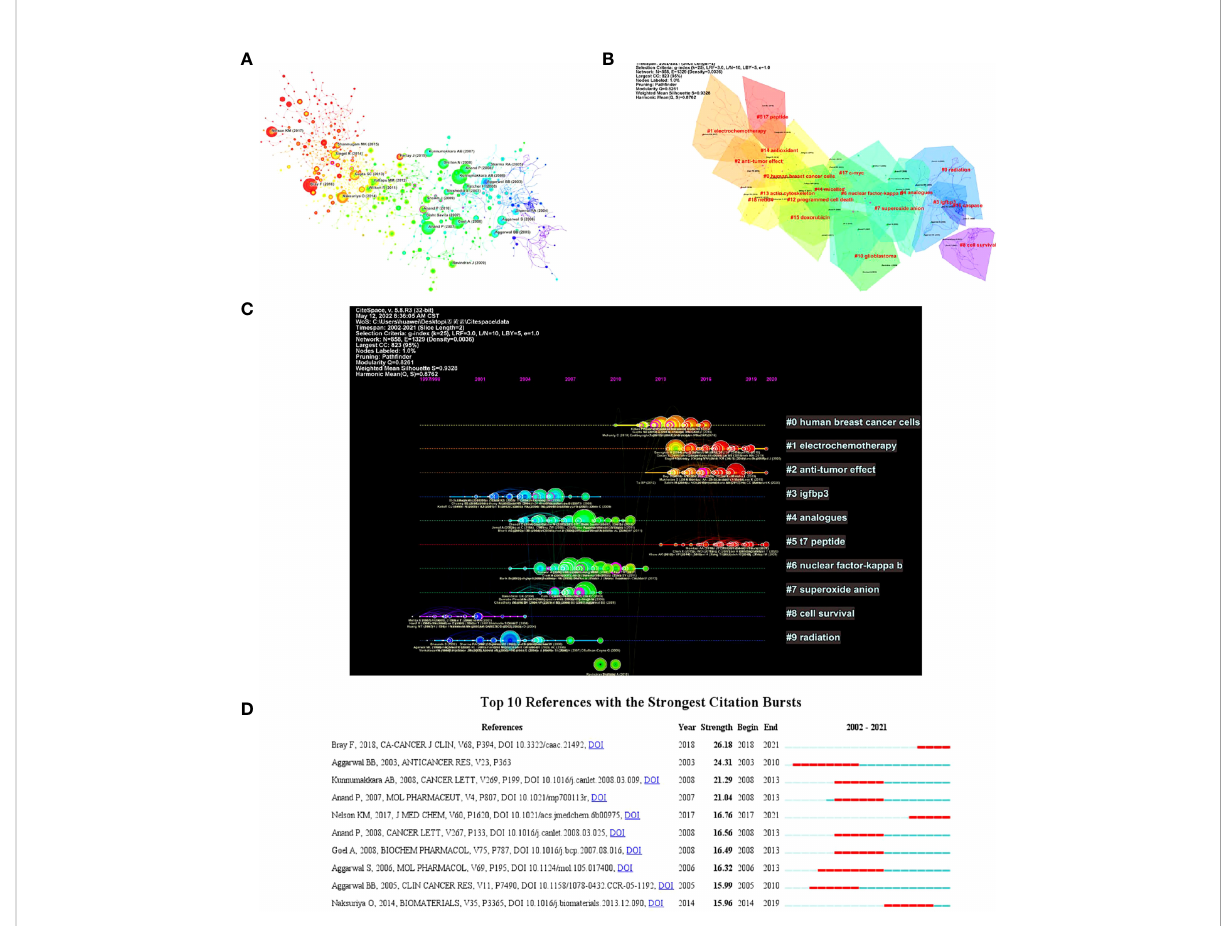
FIGURE 9 Cocitation analysis of references. (A) Network visualization analysis of co-cited References. (B) Cluster Analysis of Co-cited References. (C) Timeline view of references in the fi eld of curcumin and tumor. (D) The top 10 references with the strongest citation bursts on curcumin and tumor research.